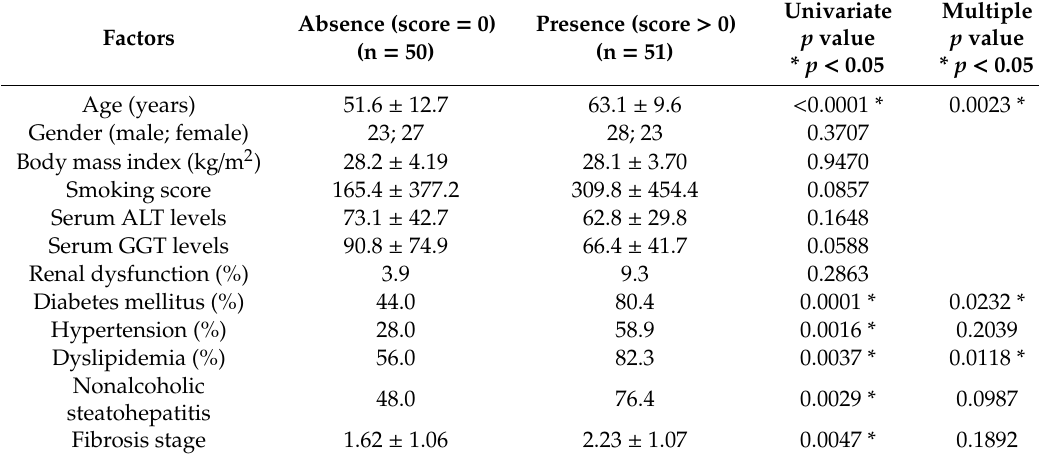
Table 3. Univariate analysis and multiple regression analysis of potential risk factors associated with Agatston score in patients with NAFLD. *, statistical significance, p value < 0.05 in Univariate and Multiple regression analysis, respectively.